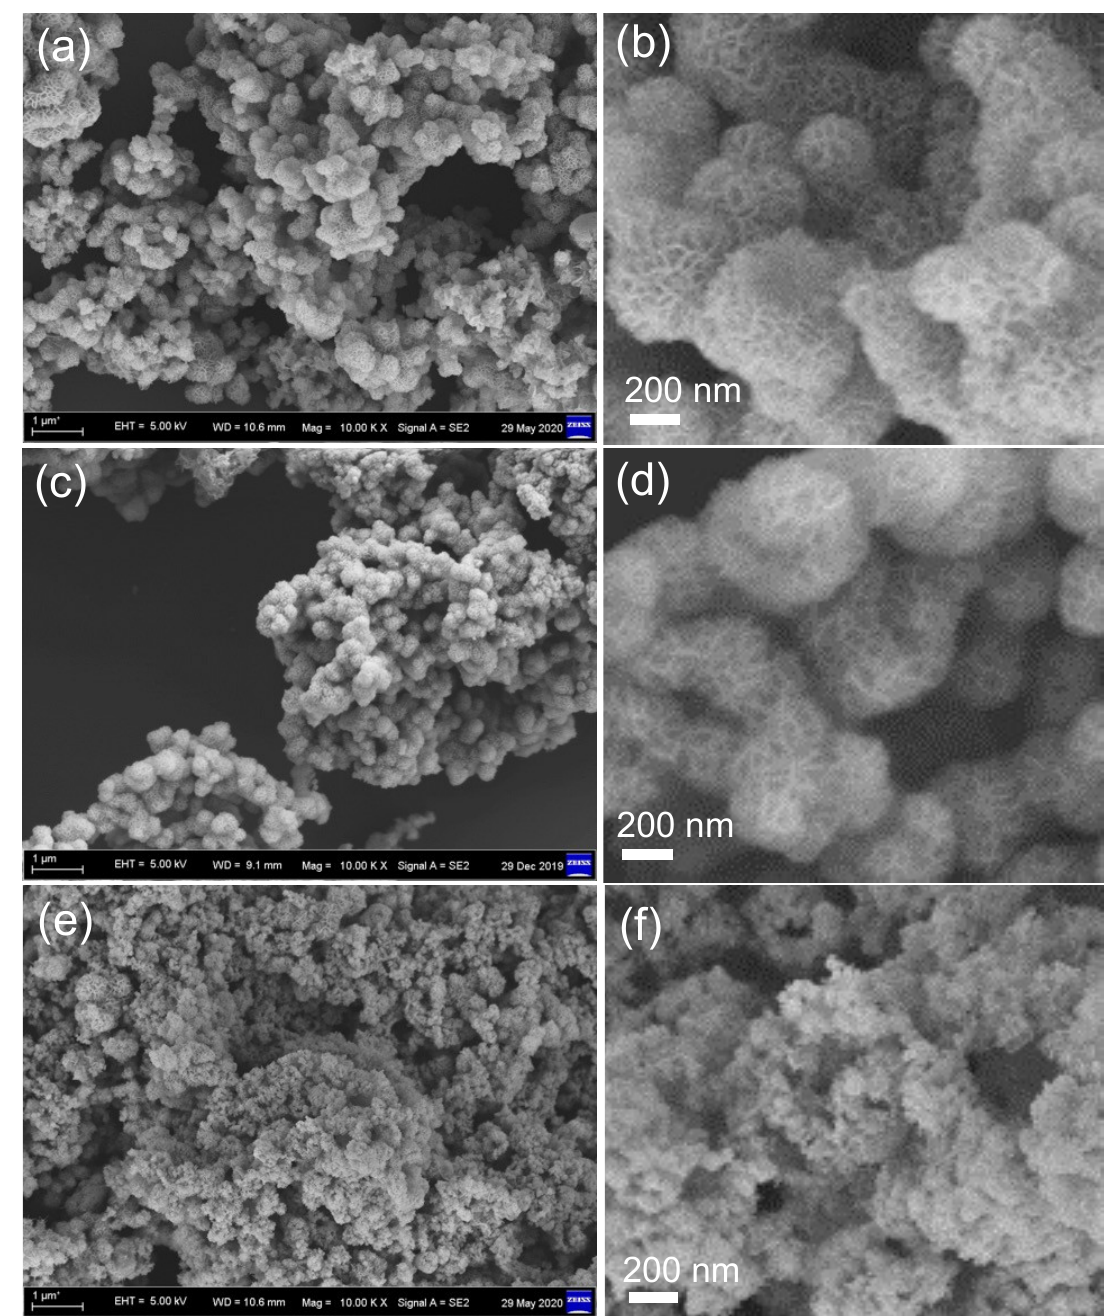
Figure 6. SEM images of the Ce/Mn-3 catalysts calcinated at different temperatures: ( a ) and ( b ) 400 °C, ( c ) and ( d ) 500 °C, and ( e ) and ( f ) 600 °C.